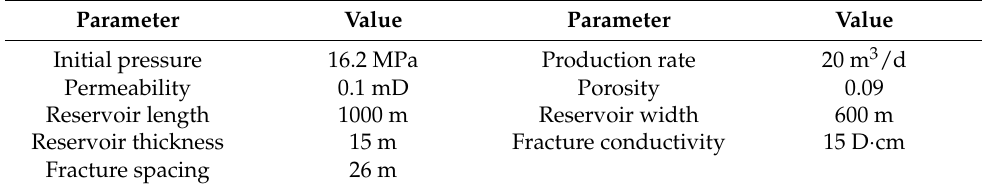
Figure 15. The regular fracture network. Table 3. Model parameters. Table 3. Model parameters.